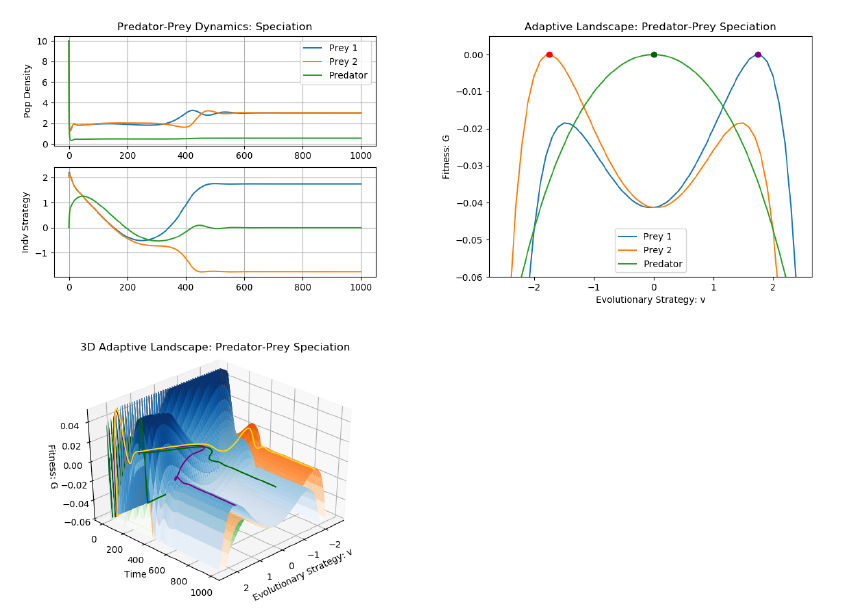
Figure 5. Predator–prey speciation event simulations. The first panel shows the population and strategy dynamics of predator (green), prey 1 (blue/purple), and prey 2 (orange/gold). The second panel shows the adaptive landscape at equilibrium and the third panel is the 3D adaptive landscape (for visualization purposes, fitness values above 0.05 were truncated). Again, the adaptive landscape greatly changes over time, particularly in the first half of the simulation. Speciation clearly occurs, with the prey occupying strategy peaks on either side of the predator’s (generalist)